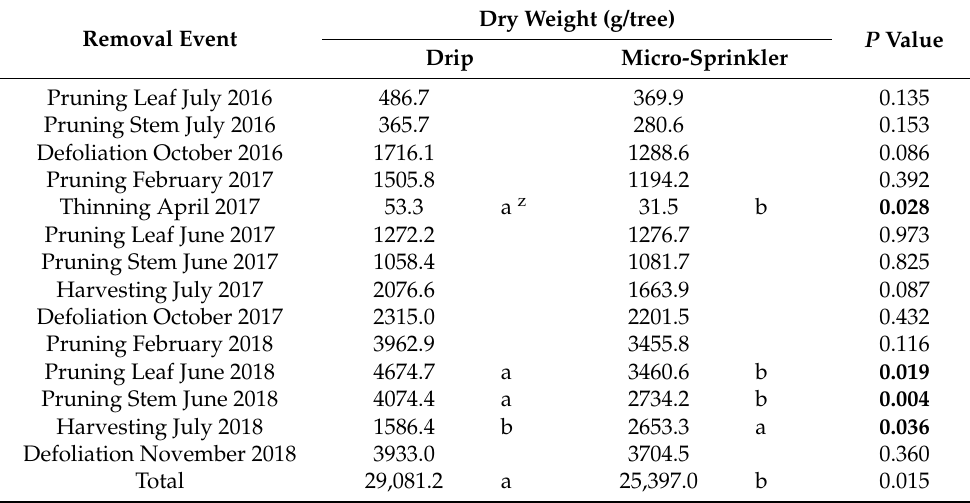
Dry Weight (g/tree)